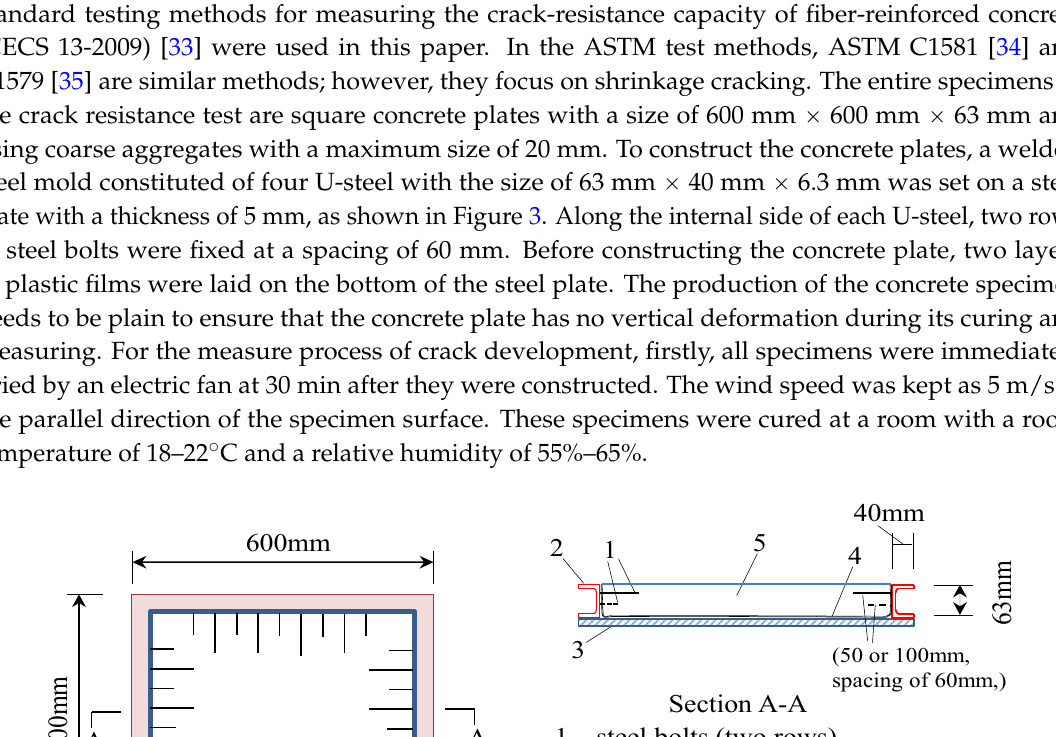
Figure 2. Instrument and method for the test of setting time. HVFAC, high volume fly ash concrete. FAC, fly ash concrete.